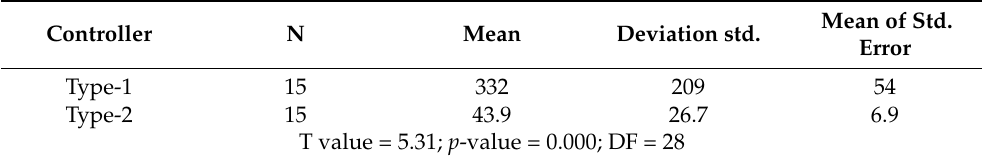
Table 7. Results for Student’s t -test using MAE error in type-1 and type-2 fuzzy controllers. Controller N Mean Deviation Std. Type-1 15 13.83 5.23 1.4 Type-2 15 9.83 2.97 0.77